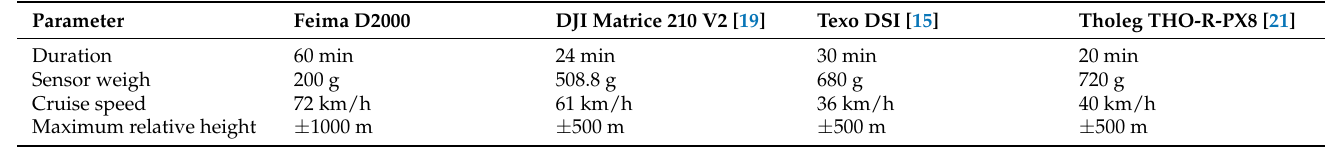
Table 2. The instrumental parameters of the UAV aerial photography